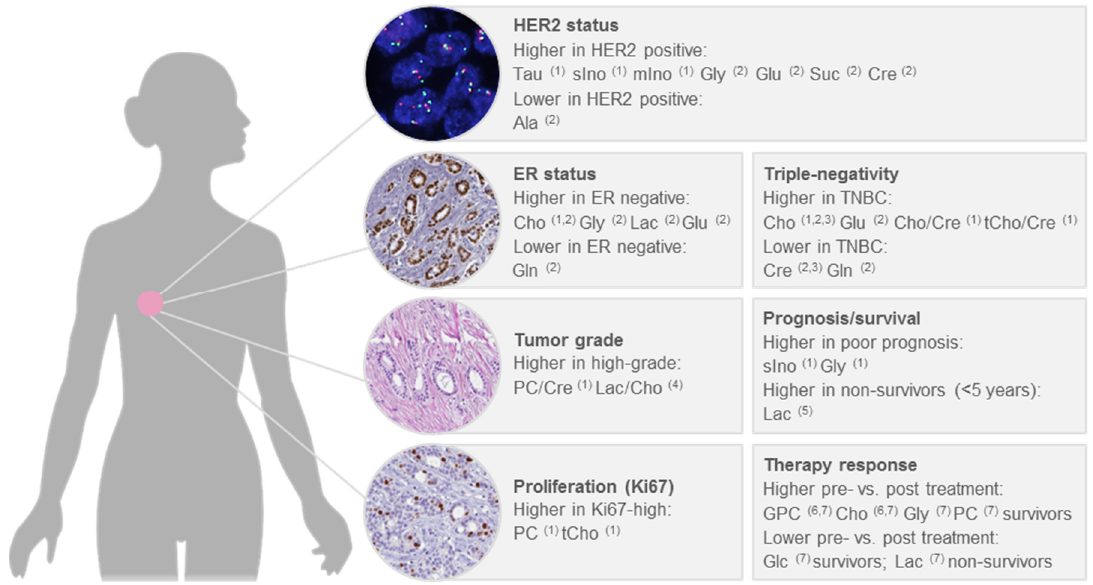
Figure 7. Significant associations of metabolite levels determined by HR-MAS NMR with clinicopathological factors in human breast cancer. 1 Choi et al. 2012 [47]; 2 Cao et al. 2014 [96]; 3 Moestue et al. 2010 [40]; 4 Cheng et al. 1998 [49]; 5 Giskeödegård et al. 2012 [85]; 6 Cao et al. 2012b [38]; 7 Cao et al. 2012a